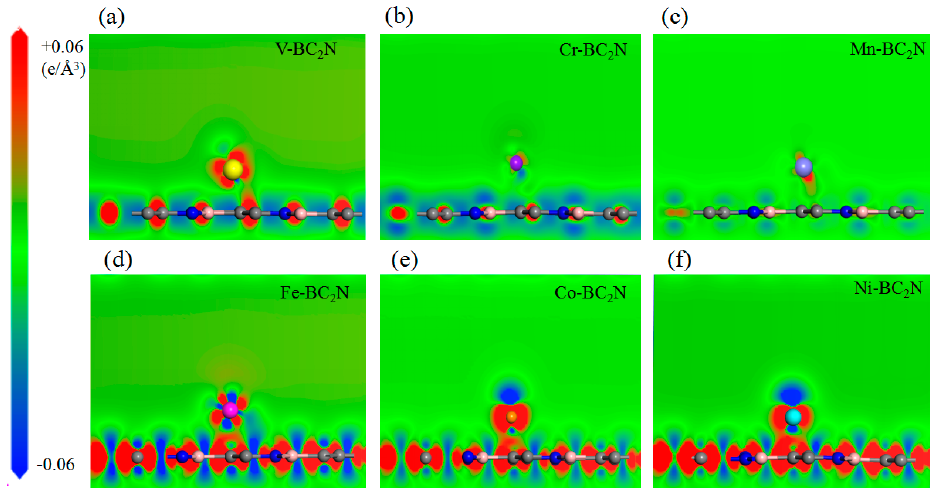
Figure 5. ( a )–( f ) The differential charge density of Ni adsorbed BC 2 N. All the adsorbed atoms